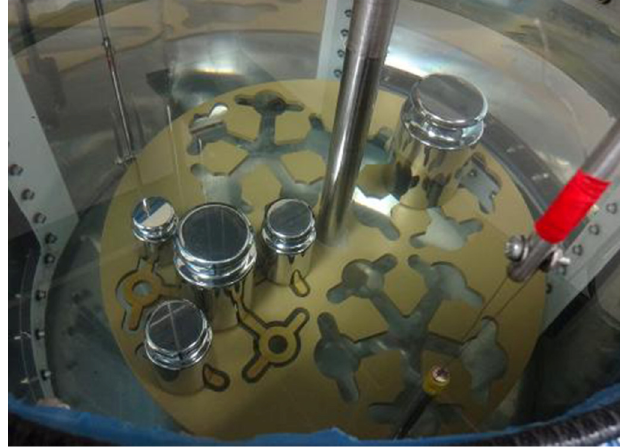
Fig. 11. The Mass Handler carries individual masses.